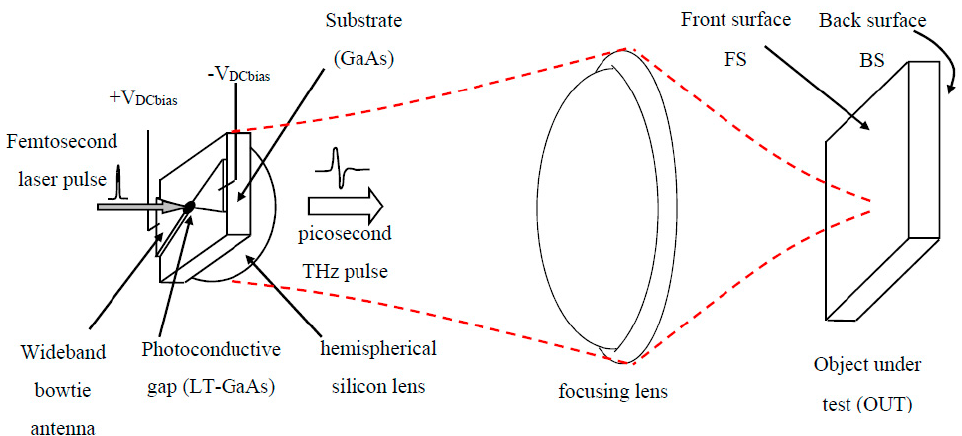
Figure 2. Structure of the photoconductive antenna and the basic measuring setup.